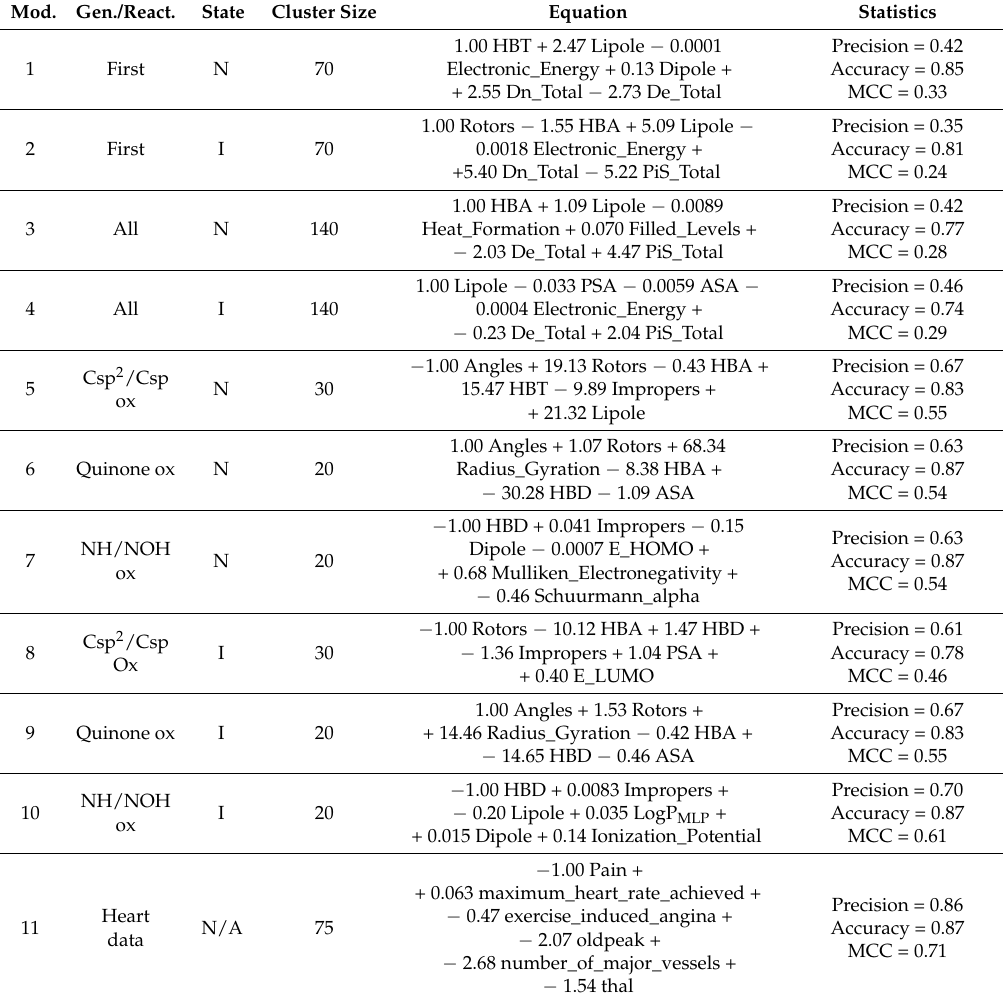
Table 2. Best developed models and relative